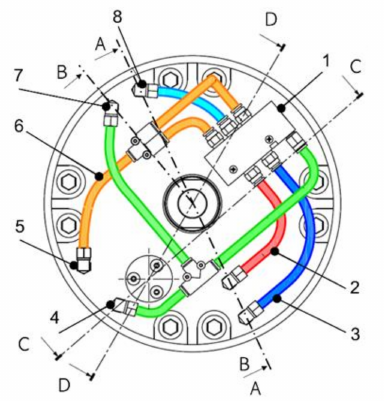
Figure 6. Main components of the pneumatic circuit: ( 1 ) 5/2 air-operated pilot valve; ( 2 ) air in- let/outlet of chamber 1; ( 3 ) air inlet/outlet of chamber 2; ( 4 ) outer limit switch pulse branch; ( 5 ) one-way flow regulator; ( 6 ) exhaust of the pilot valve; ( 7 ) inner limit switch pulse branch; ( 8 ) air inlet